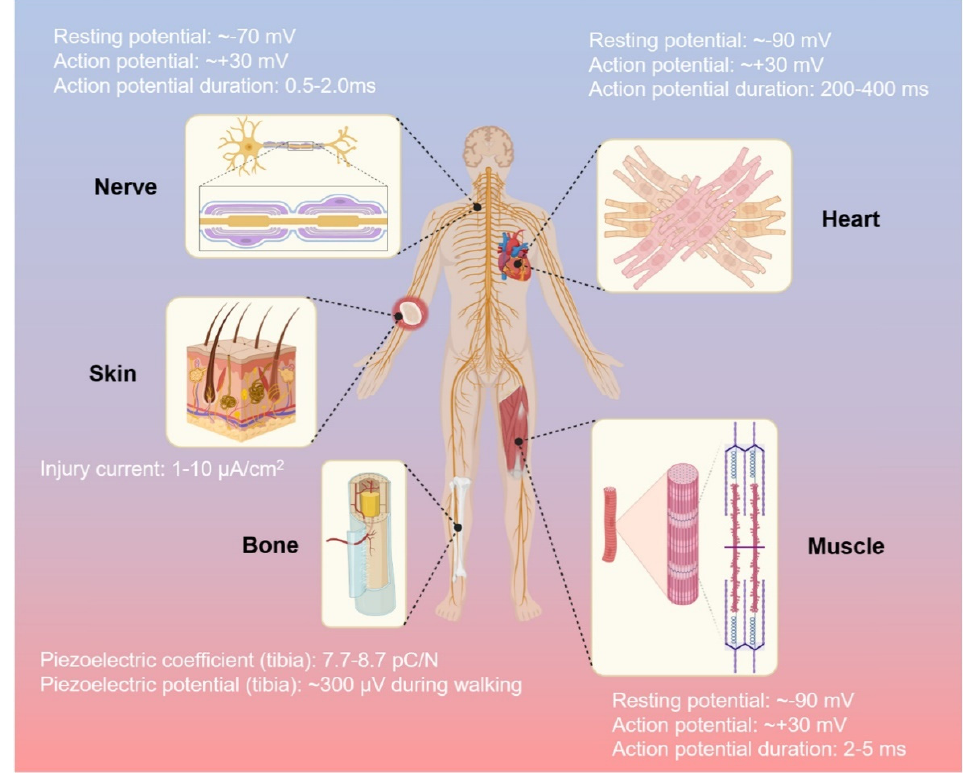
Figure 6. The human body and its electrical activity. Reproduced with permission from [97]. Copyright (2021) Elsevier.